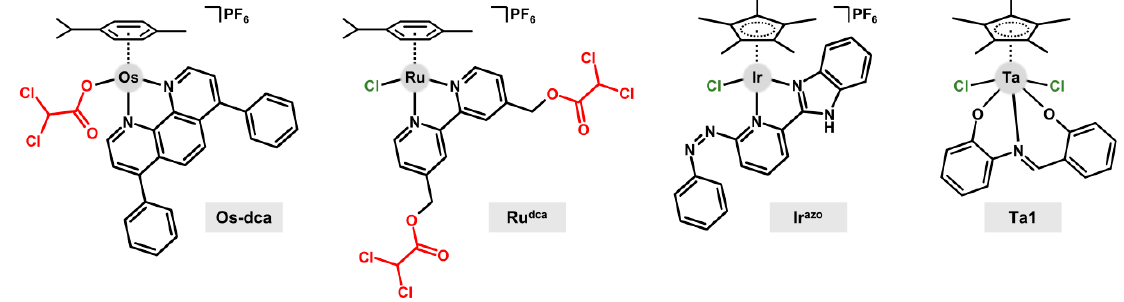
Figure 8. Structural formulas of complexes [Os( η 6 -pcym)(bphen)(dca)]PF 6 ( Os-dca ), [Ru( η 6 -pcym)(bpy dca )Cl]PF 6 ( Ru dca ), [Ir( η 5 -Cp*)Cl(L2 azo )]PF 6 ( Ir azo ), and [Ta( η 5 -Cp*)Cl 2 (L3)] ( Ta1 ); bioactive ligand/substituent dichloroacetate is given in red.